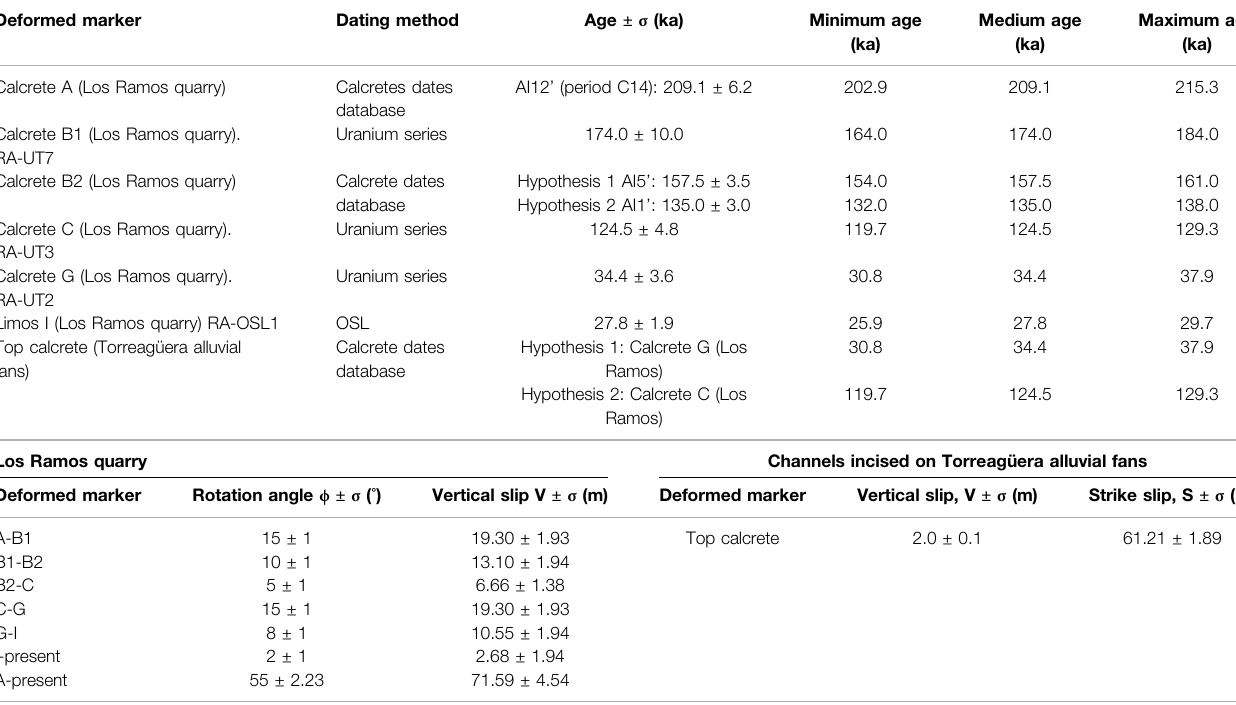
TABLE 1 | Summary of the deformed marked on the Los Ramos quarry and Torreagüera alluvial fans, dating methods used, ages obtained and theirs uncertainty ranges. Rotationangles( φ )measured betweendeformedmarkersontheLosRamosquarryandverticaloffsets(V)estimated. Vertical(V)and strike(S)displacements measured in the channels incised on Torreagüera alluvial